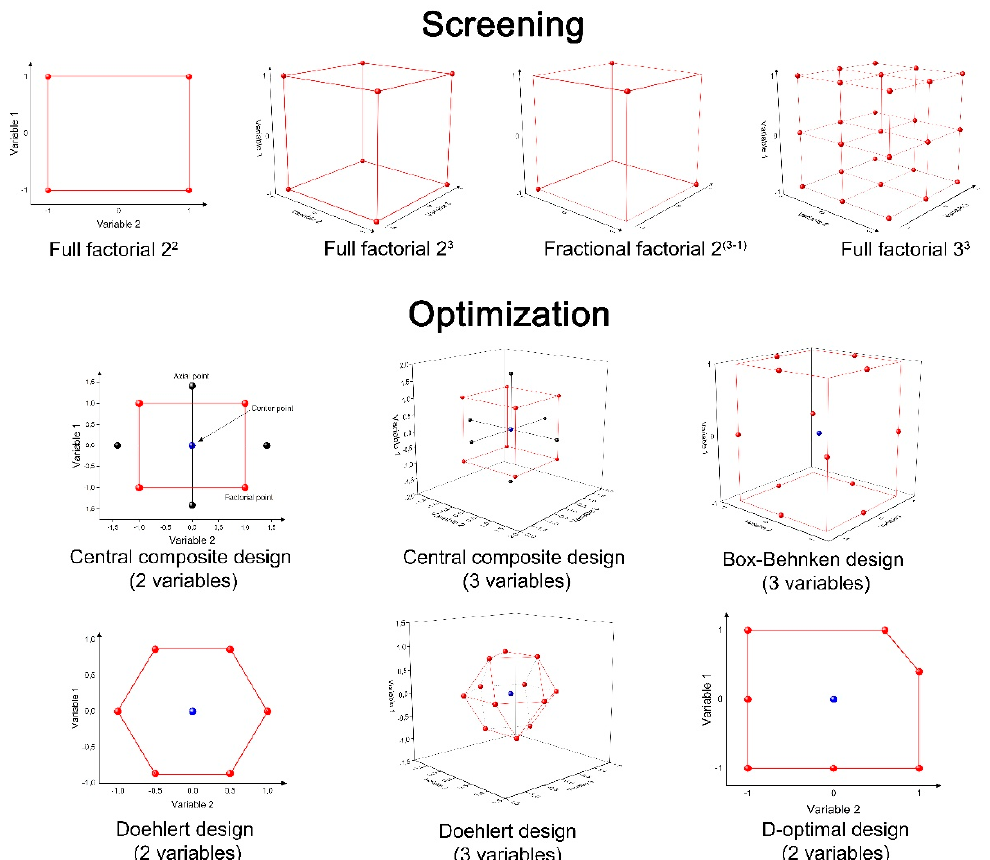
Figure 1. Experimental domain of the most common experimental designs.